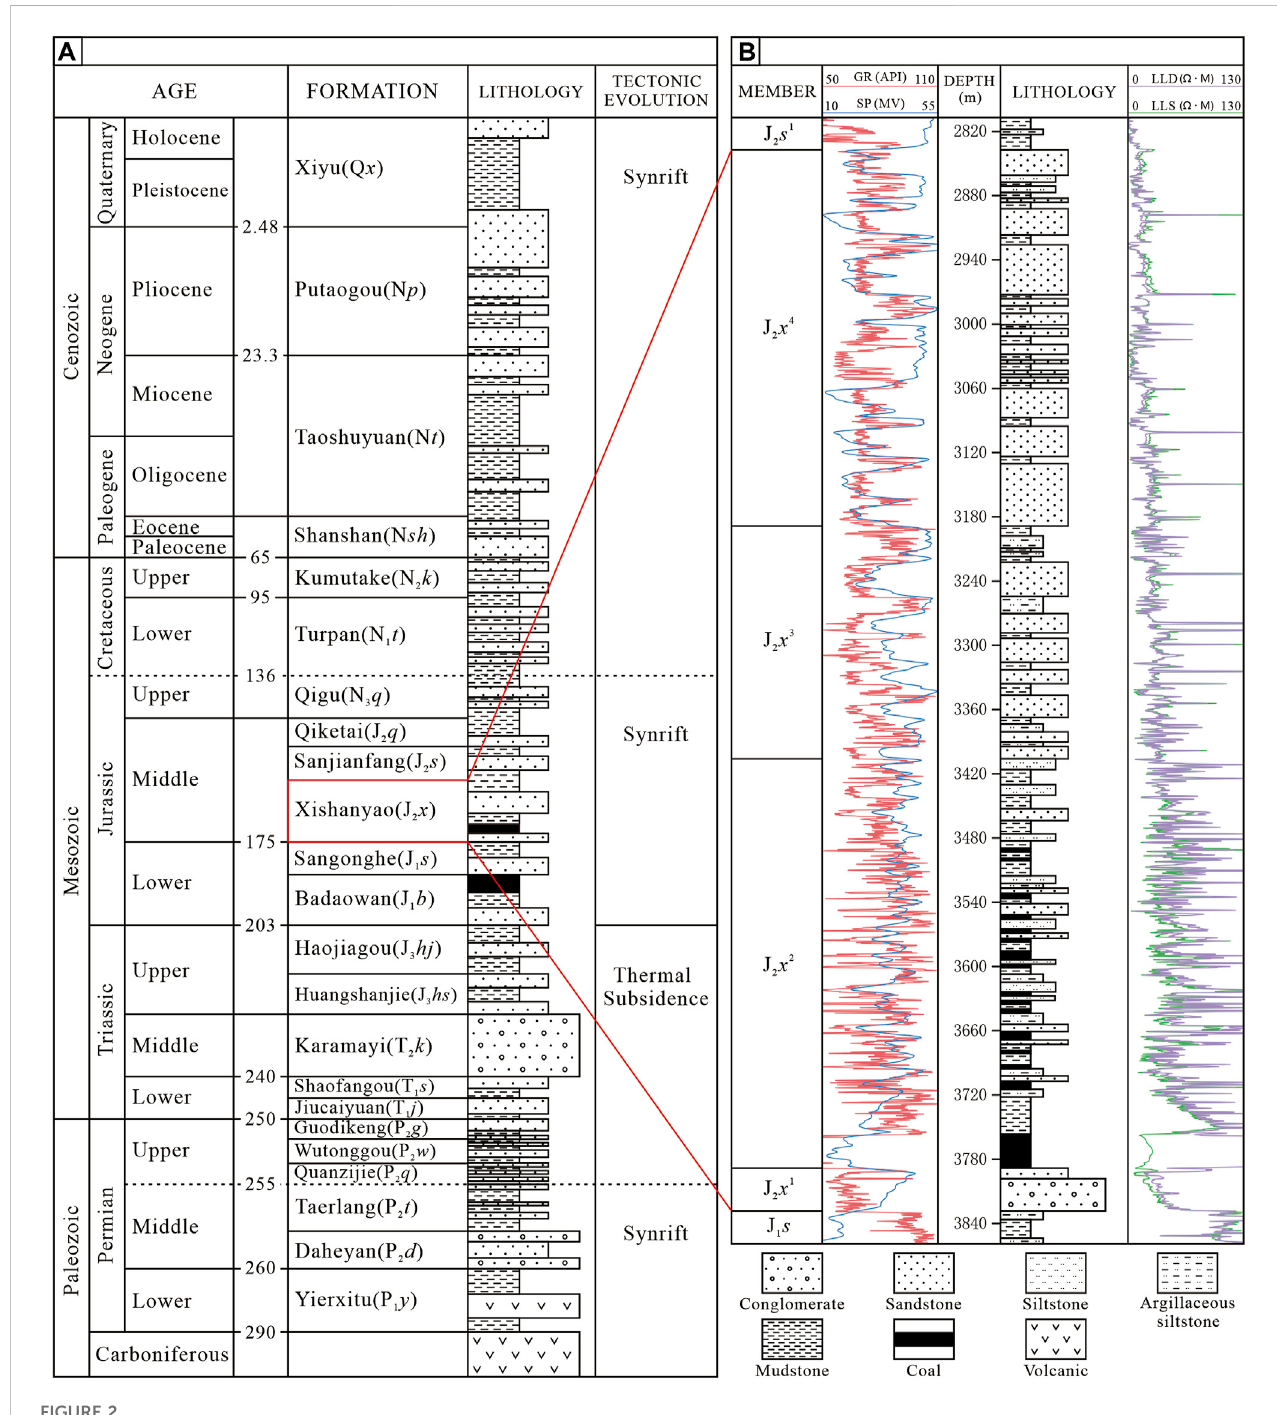
Frontiers in Earth